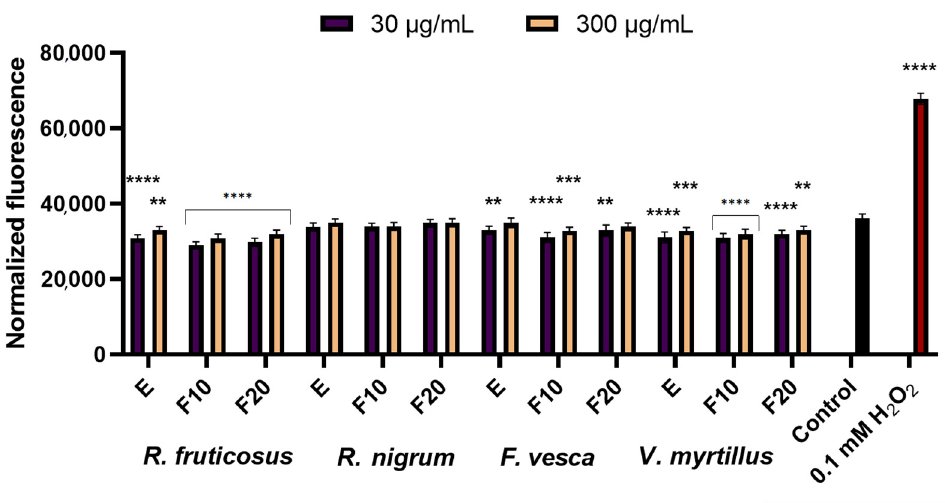
Figure 2. Effect of R. fruticosus L., R. nigrum L., F. vesca L., V. myrtillus L. extract and kombucha ferments (at concentrations of 30 μ g/mL and 300 μ g/mL) on the DCF fluorescence in fibroblasts (BJ). Data are the mean ± SD of three independent experiments, each consisting of three replicates per treatment group. **** p < 0.0001, *** p < 0.0010, ** p < 0.0020 versus the control.